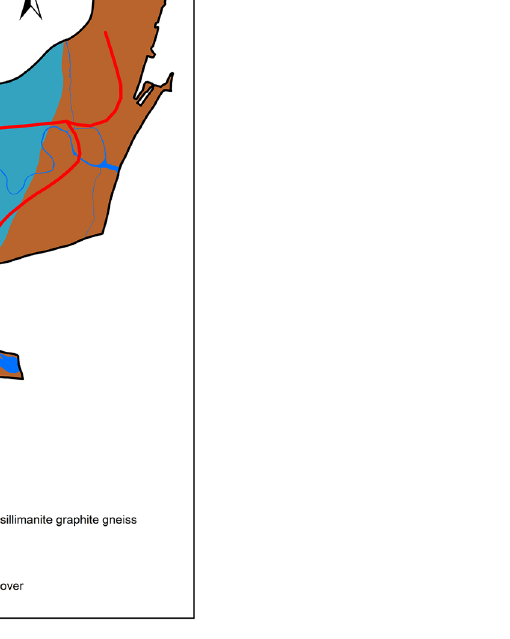
Figure 4. Geological classifications of Study